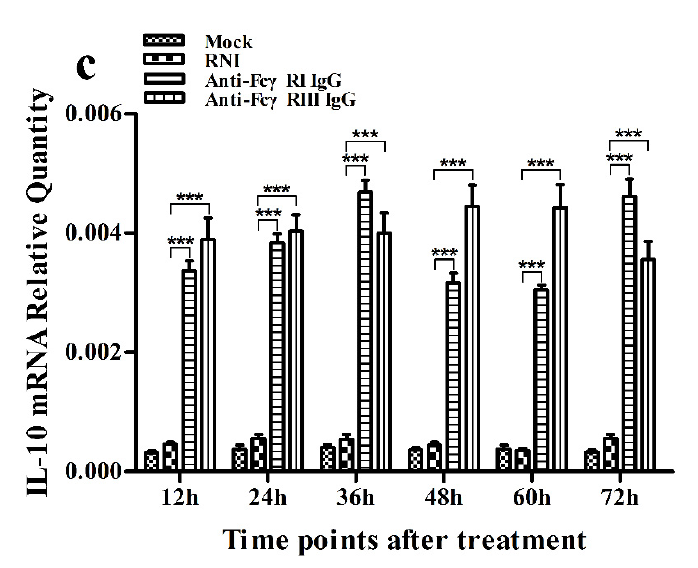
Figure 9. Effect of Fc γ RI or Fc γ RIII on mRNA expression of cytokines in porcine AMs. Relative quantitative RT-PCR analysis of cytokine mRNA levels in cells treated with RNI, anti-Fc γ RI IgG or anti-Fc γ RIII IgG. ( a ) IFN- α mRNA level, ( b ) TNF- α mRNA level, ( c ) IL-10 mRNA level. *** p < 0.001.